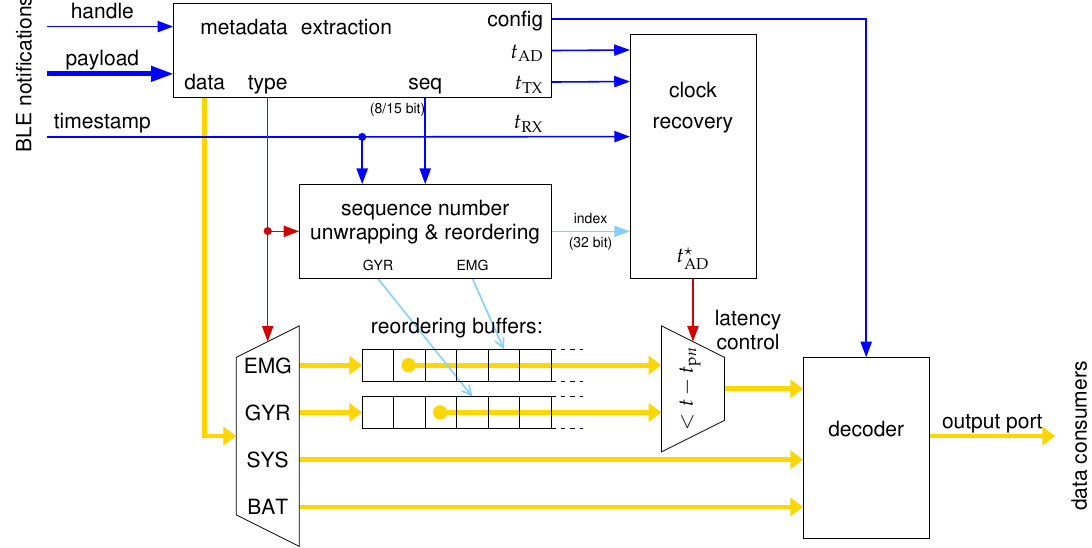
Figure 6. Block diagram of the data flow within the receiver software. Only one output port is shown, the “latency control” block is replicated for each port using a different value of the latency t p n , n being the port